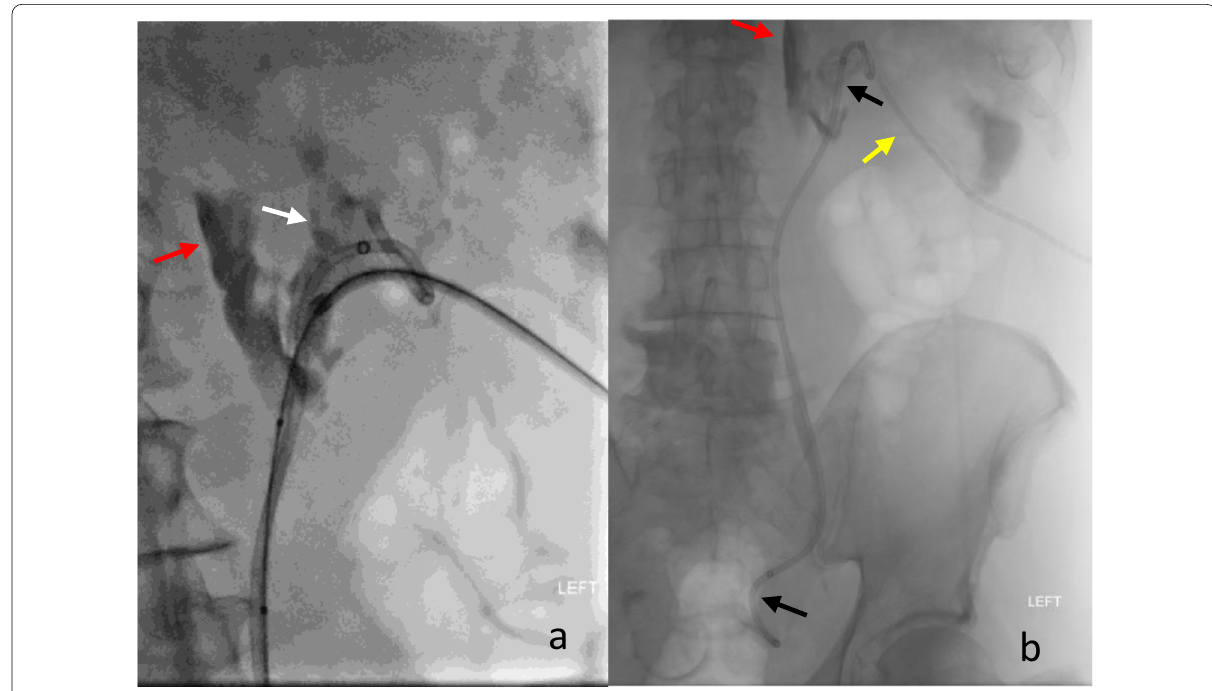
Fig. 13 Selected AP fluoroscopic acquisitions during percutaneous nephrostomy (PCN) exchange and insertion of an antegrade stent. a Magnified projection demonstrating extravasation of contrast (red arrow) and opacification of the collecting system (white arrow). b Acquisition on completion demonstrating PCN (yellow arrow) and position of the antegrade stent (black